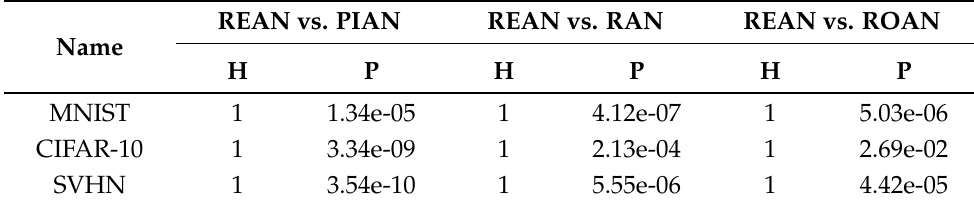
Table 2. Paired t -tests on MNIST, CIFAR-10 and SVHN